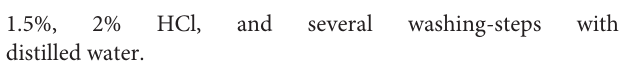
of SC. The MT05 instrument is similar to a Höppler